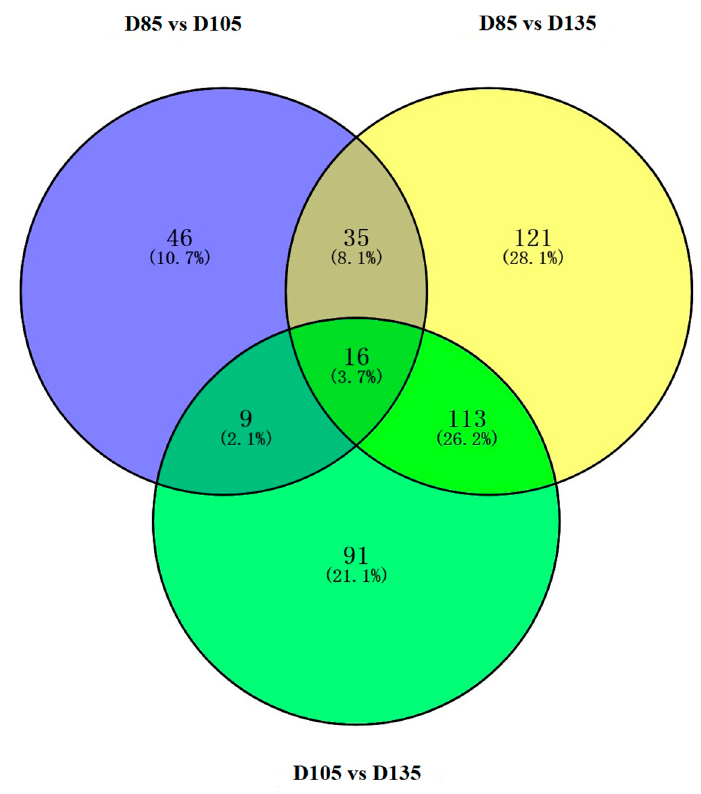
Figure 1. Venn diagrams of the pairwise comparison of differentially expressed miRNA in three groups (D85 vs. D105, D105 vs. D135, and D85 vs. D135).